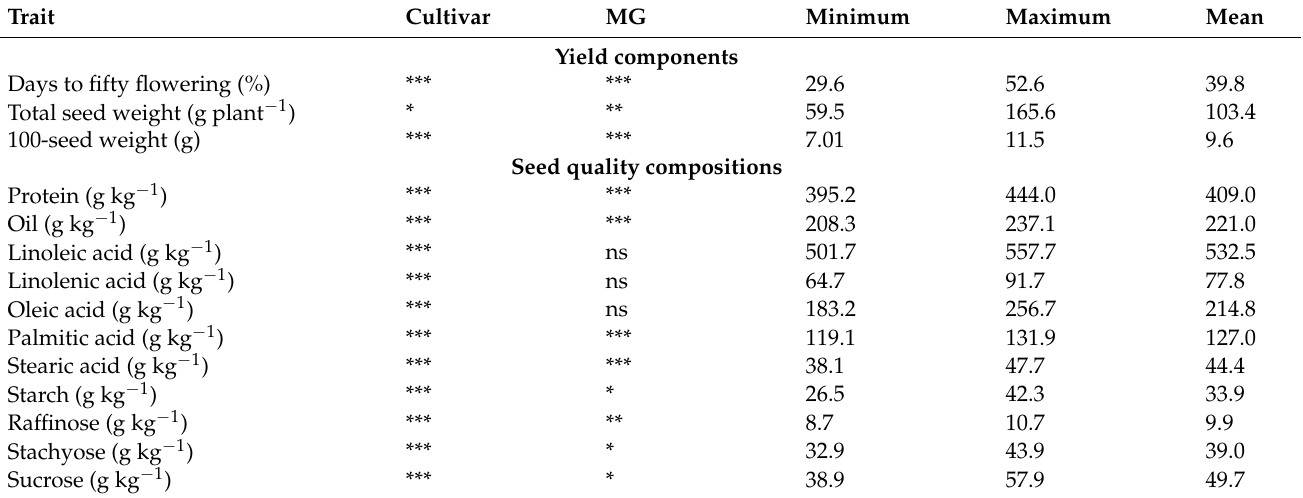
Table 1. Summary of 18 soybean cultivars yield components and quality parameters grown under well-watered and fertilized conditions.